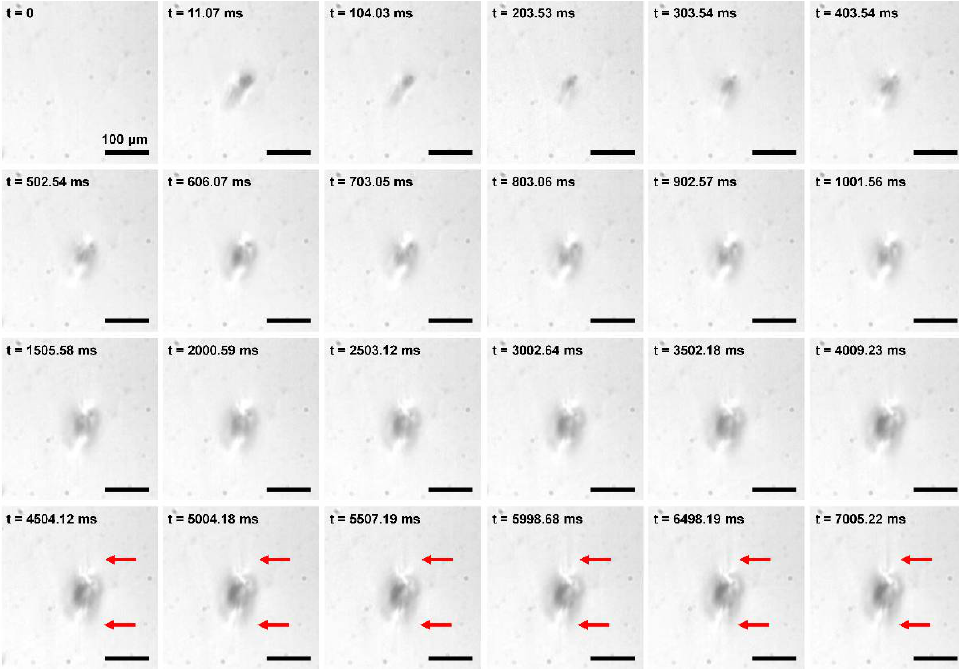
Figure 3. Time-lapse snapshot of the PDMS film during continuous XFEL exposure. The verticallinear features developed around the beam transmission area, due to radiation damage, are indicated by red arrows.